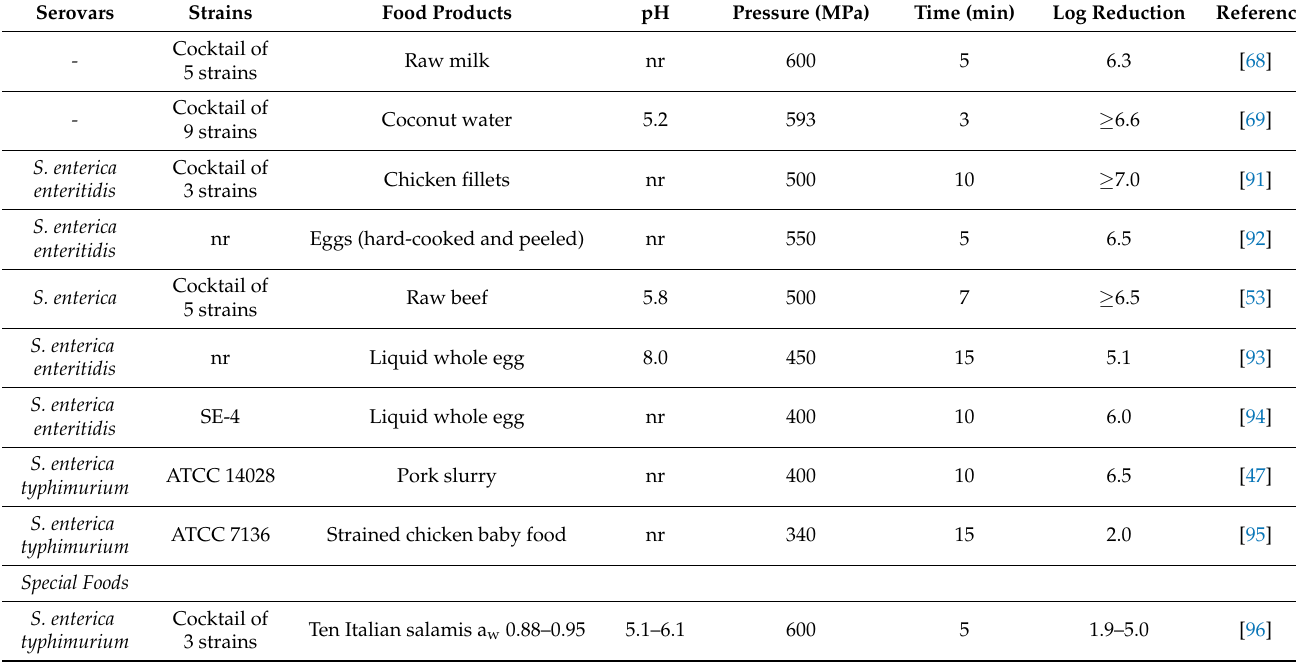
Table 4. Inactivation of Salmonella in foods by high-pressure processing (HPP)